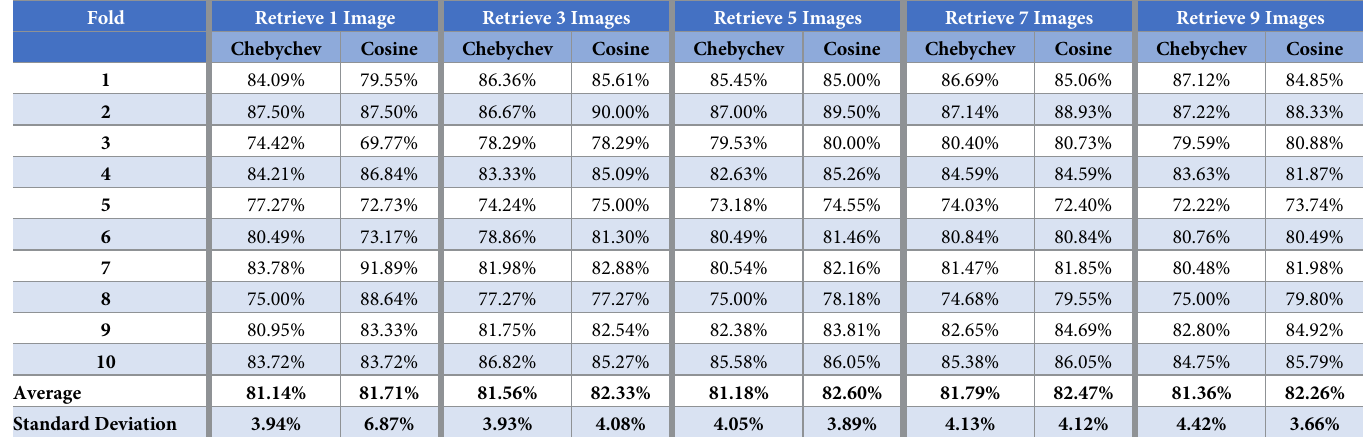
Table 3. Accuracy of OtoMatch while retrieving 1, 3, 5, 7, and 9 images for each 10-fold. Fold